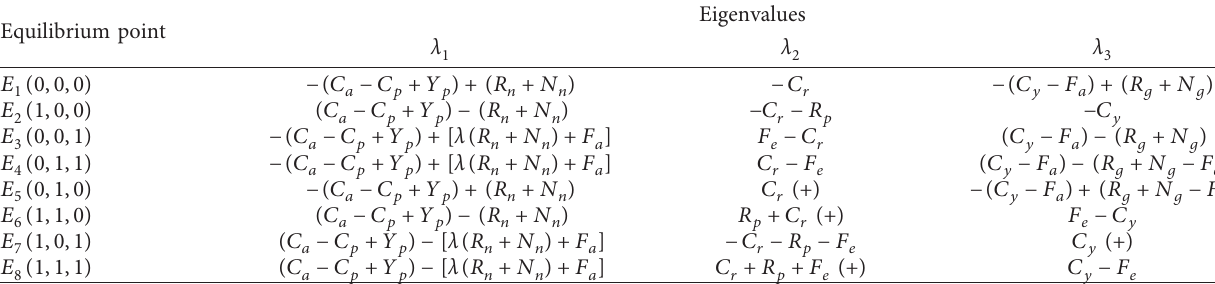
Table 2: The eigenvalues corresponding to each equilibrium point.